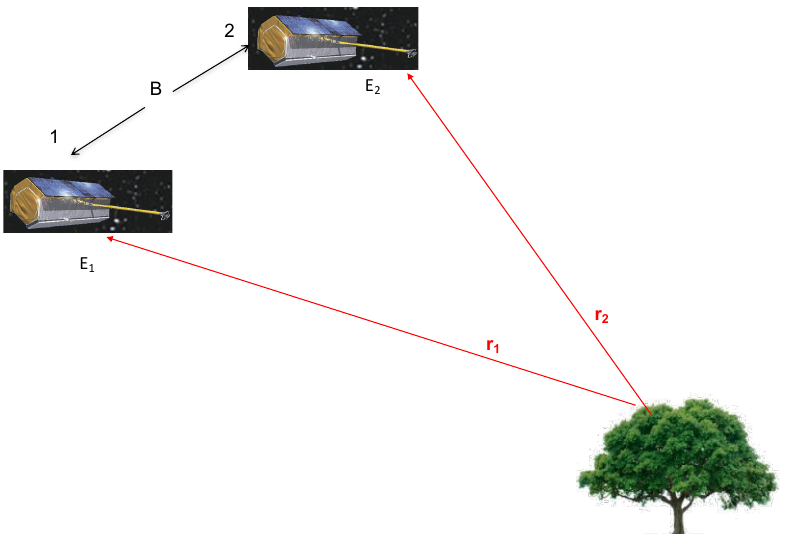
Figure 2. Schematic representation of the InSAR scattering geometry. The fields scattering from a single scattering element, the top of the tree, travel along the distances r 1 and r 2 to the ends of the interferometer. This difference is proportional to interferometric phase and to the height of the single scattering element. The interferometric phase resulting from many scattering elements (the volume of the forest) is used to characterize vertical structure in this